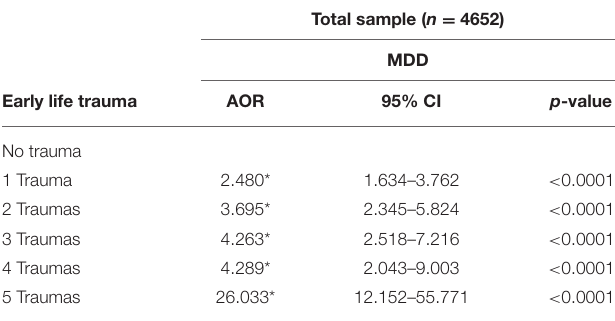
TABLE 3 | Results of multivariable logistic regression analysis of risk of developing major depressive disorder for frequency of reported early life trauma in